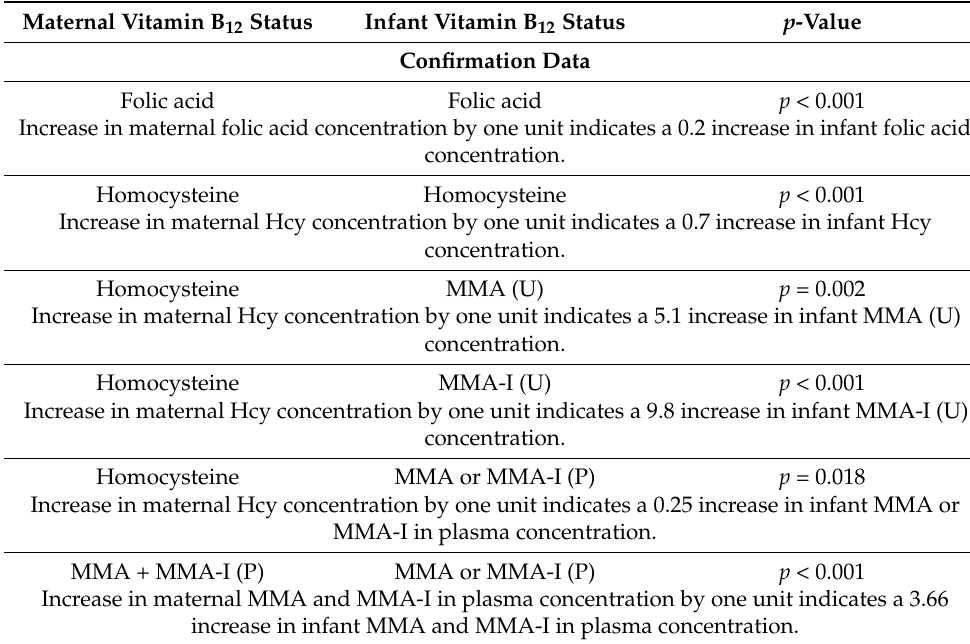
Table 4. Effect of maternal vitamin B 12 status on infant